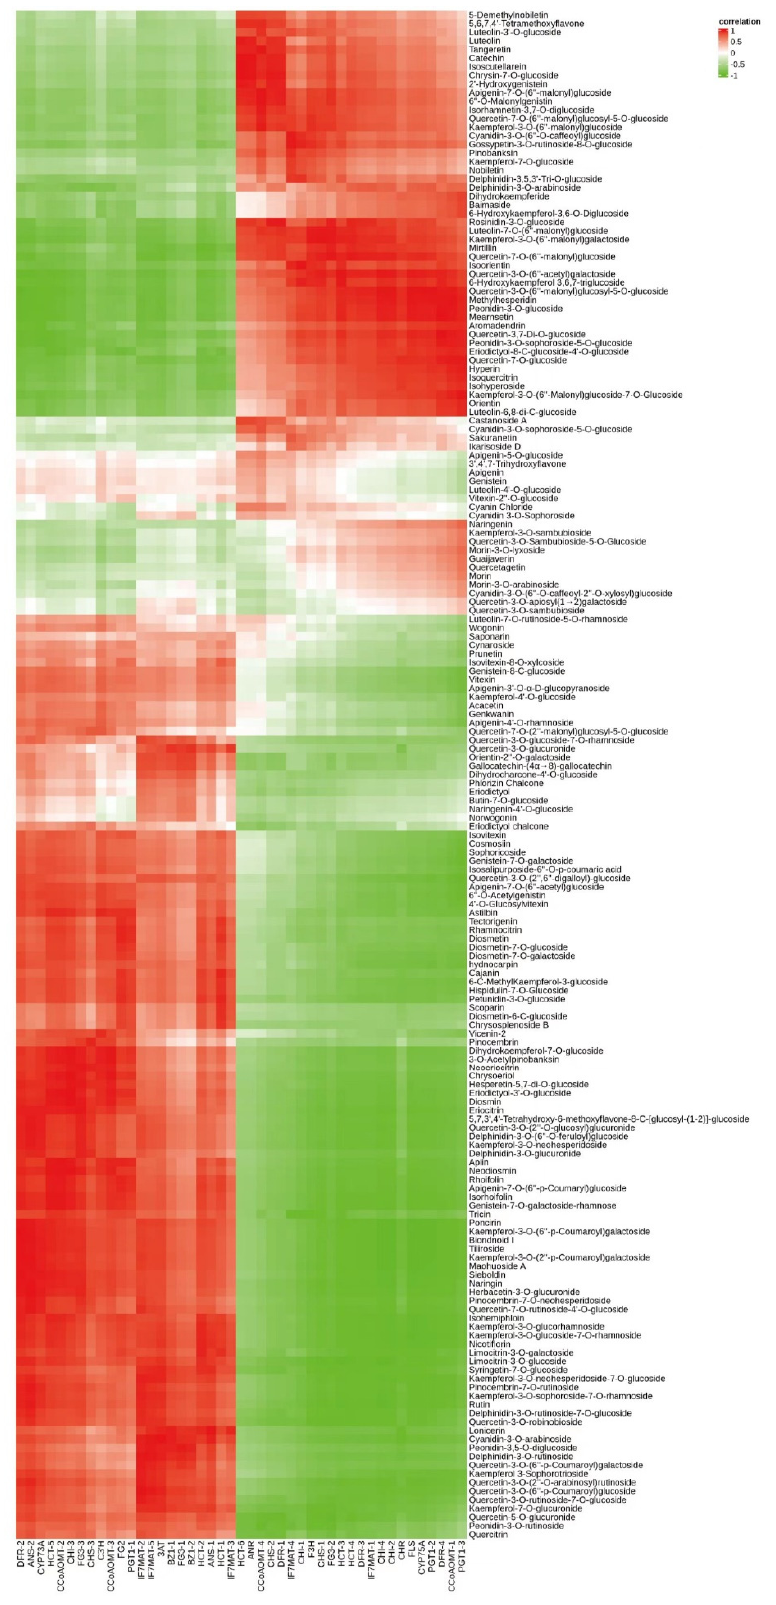
Figure 7. Correlation analysis of flavonoids and flavonoid synthesis genes in flowers of Clematis tangutica (Maxim.) Korsh.